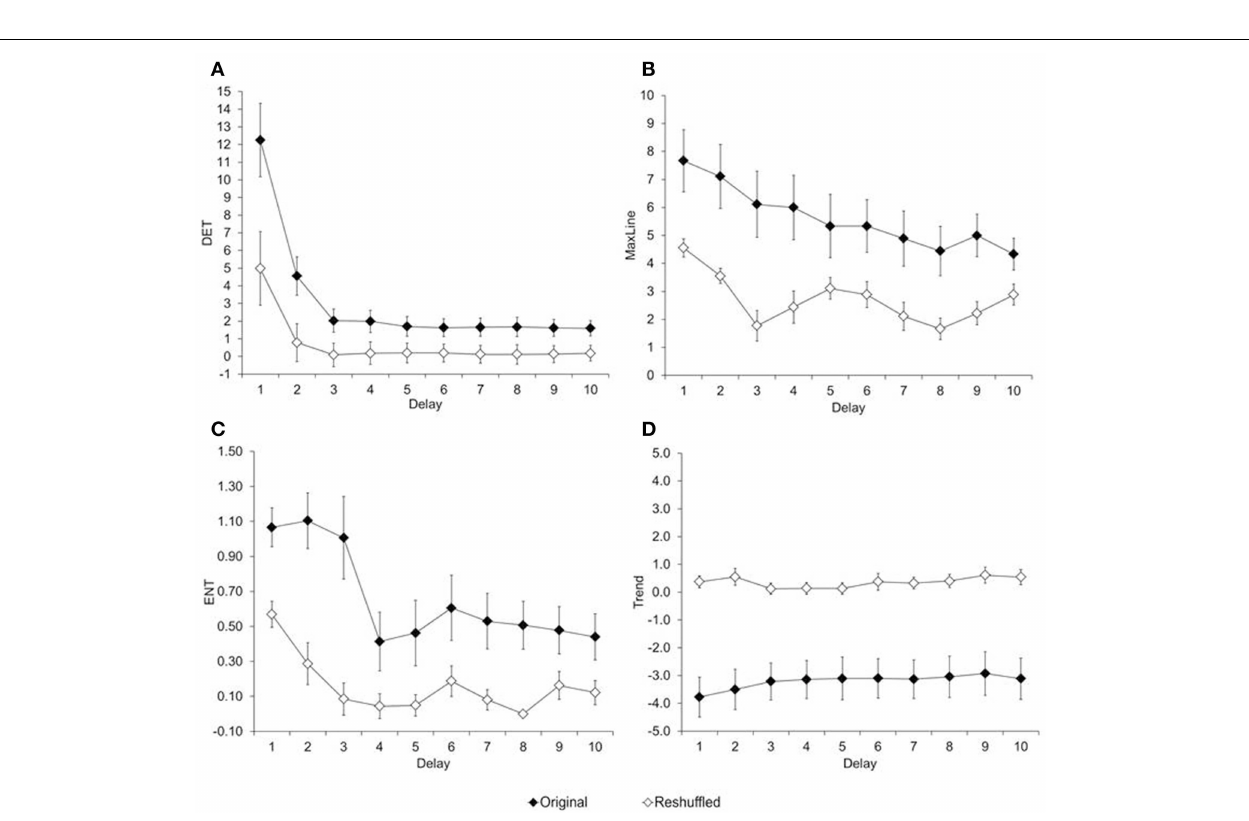
FIGURE 3 | (A) Difference between the Hurst exponents determined for the original time series and the randomly reshuffled time series, shown as a function of participants’ age. Asterisk show the average difference for children (gray) and adults (black), respectively.